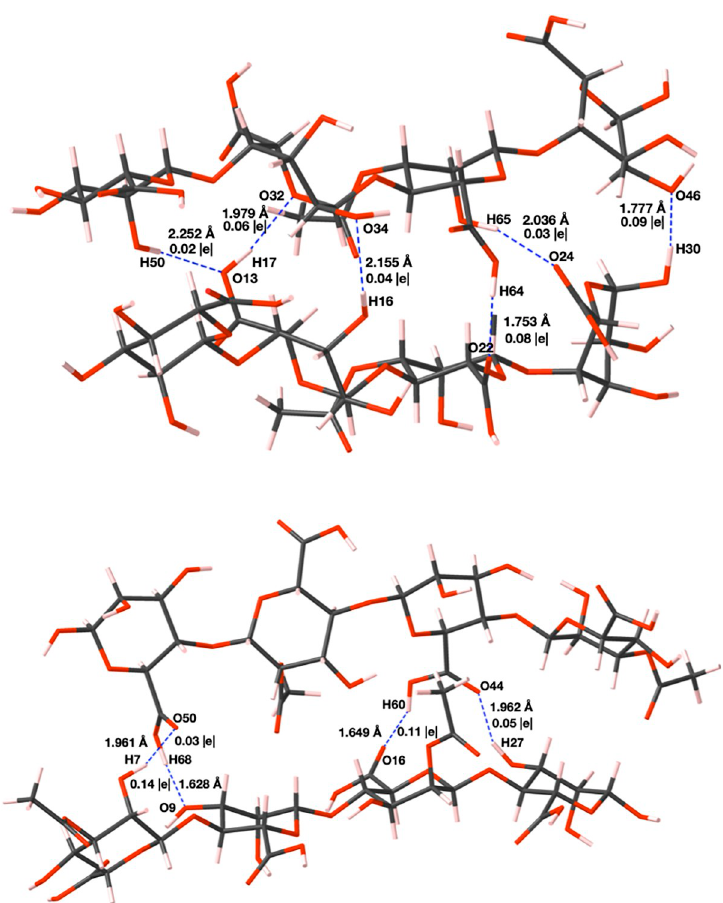
Fig 2. Antiparallel arrangement of two PolyM structures (PolyM (ap) , top) and parallel arrangement of two PolyMG structures (PolyMG (P) , bottom). Carbon atoms are shown grey, oxygen red and hydrogen pink. Hydrogen bonds between chains are shown as blue dashed lines and the Mulliken populations and lengths of these bonds are